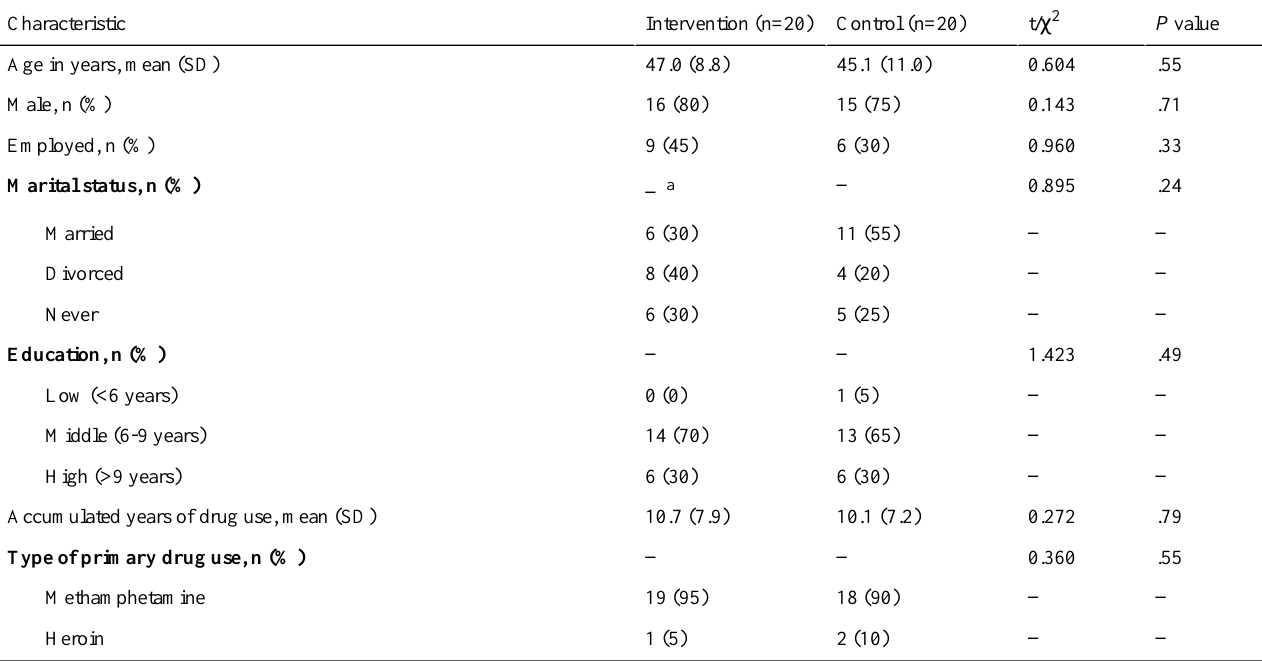
Table 1. Baseline and demographic characteristics of participants